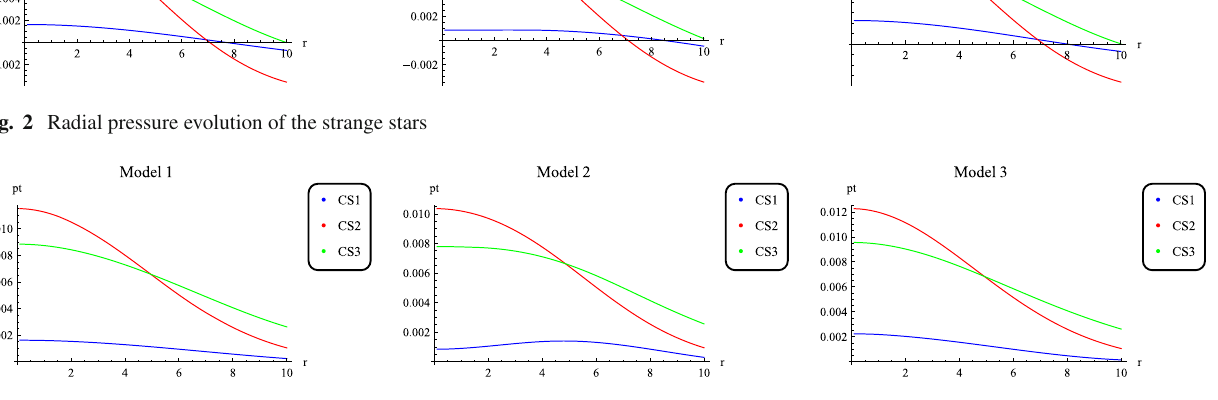
Fig. 3 Transverse pressure evolution of the strange